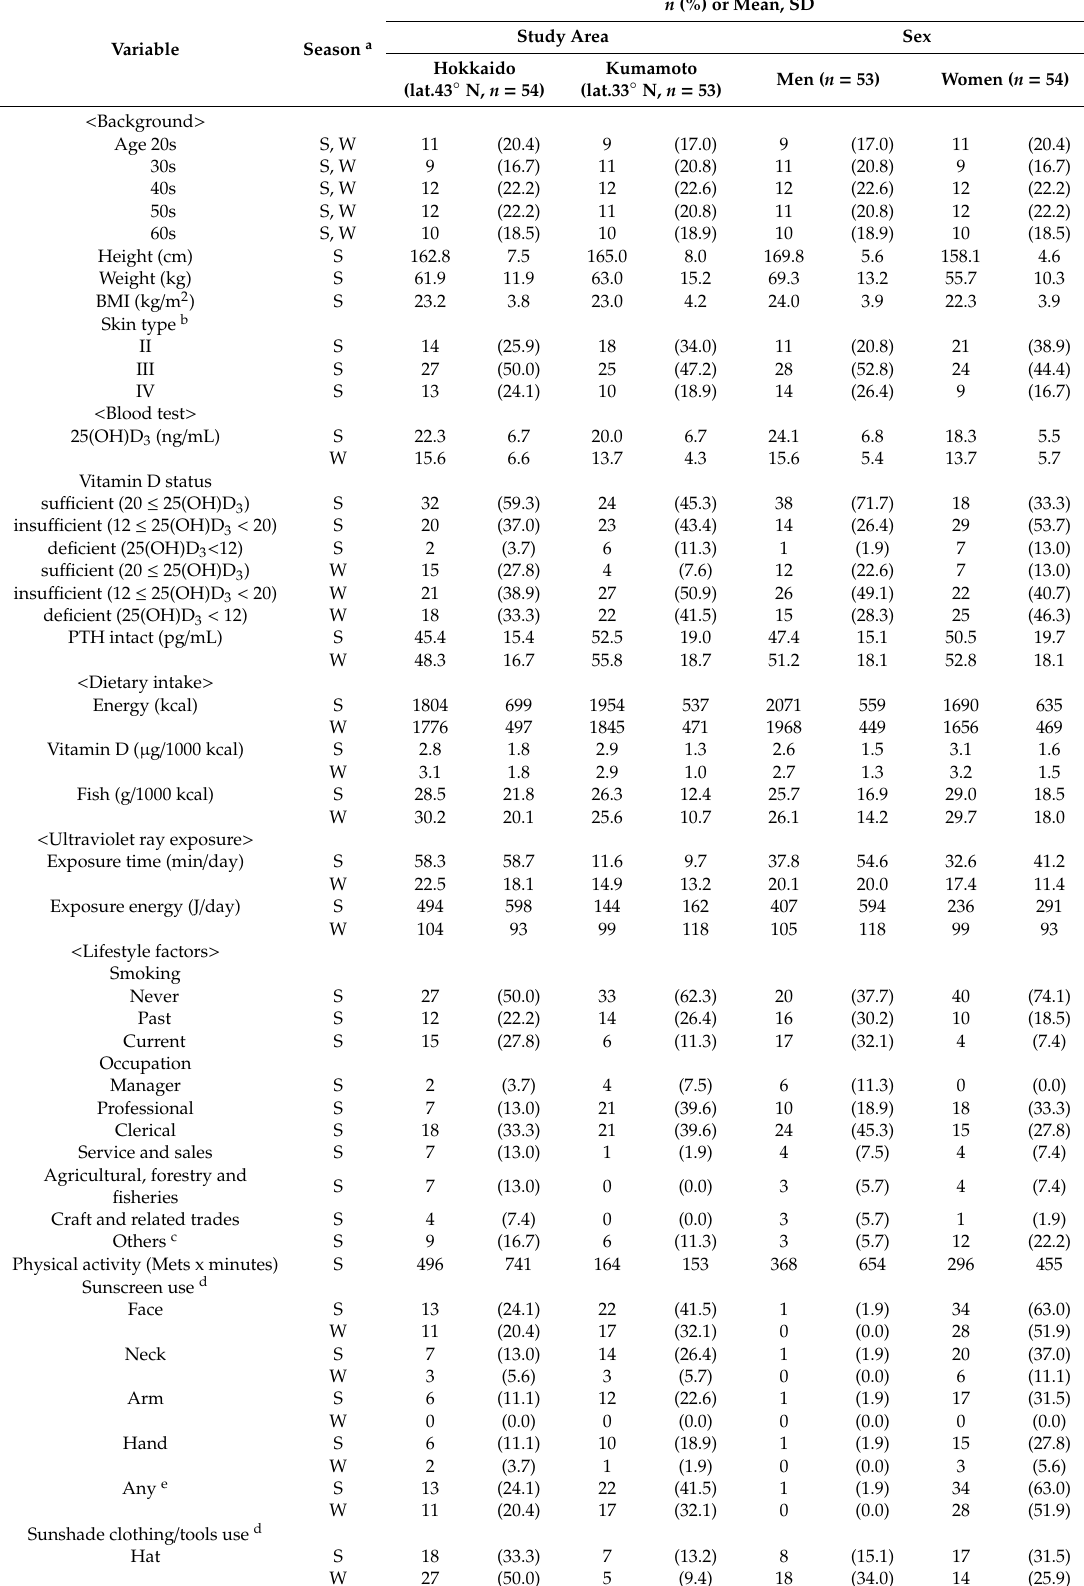
Table 1. Characteristics of participants (total participants: n =